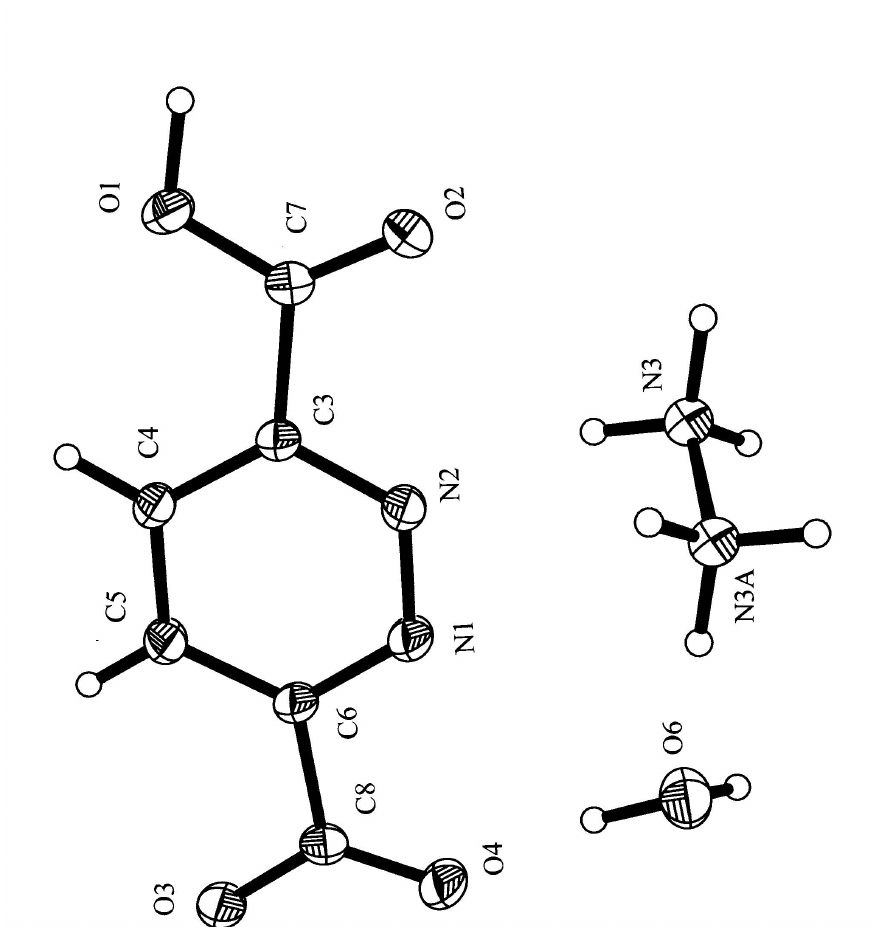
The asymmetric unit with atom labelling scheme and 50% probability displacement ellipsoids. The hydrazine cation is symmetry complete (symmetry code: (A) - x + 1, - y + 1, - z +